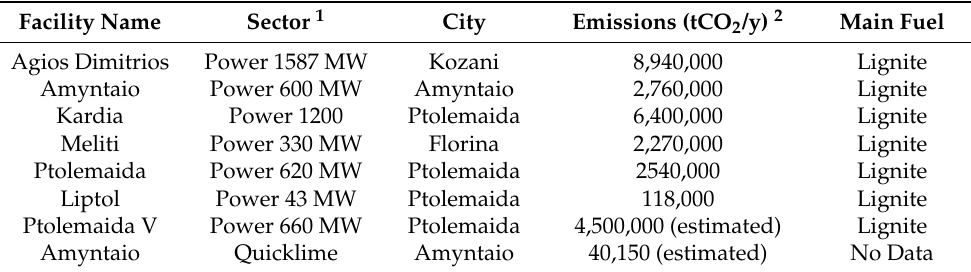
Table 3. Information on industrial plants in Western Macedonia and their annual CO 2 emissions up to year